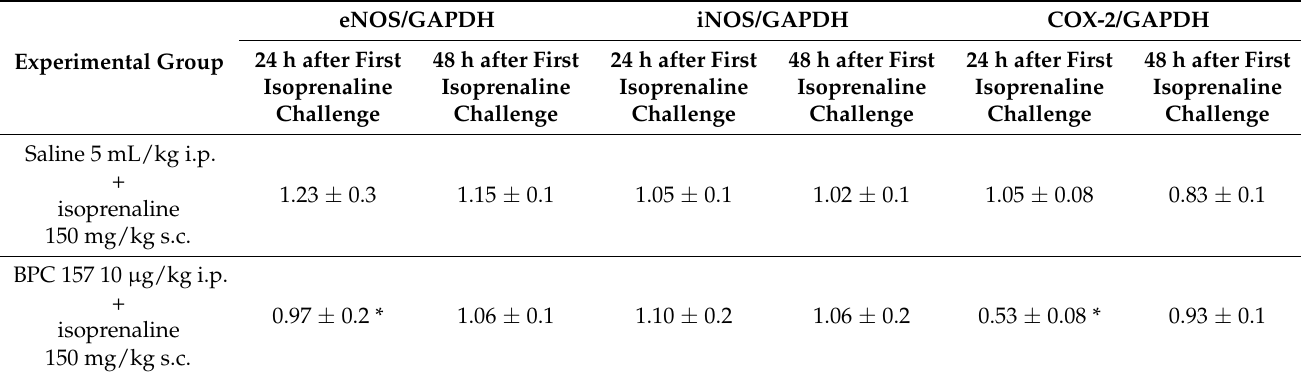
Table 4. eNOS/GAPDH, iNOS/GAPDH, COX-2/GAPDH. Densitometric analysis of RT-PCR prod- ucts showing the effect of BPC 157 on eNOS and COX-2 mRNA levels in heart septum tissue. Results were expressed as the ratio of the optical density of the eNOS PCR and COX-2 products to the density of the corresponding GAPDH PCR products and standardized to 1.0 for controls (relative intensity). Isoprenaline (150 mg/kg s.c., given once (at time 0) or twice, at 0 and 24 h). First challenge for initial infarction induction, assessed at 24 h thereafter; then, at 24 h, the next application (isoprenaline given twice, at 0 and 24 h) for reinfarction induction (assessment at the end of the subsequent 24 h period). Medication (/kg, i.p.) (BPC 157 (10 µ g) or saline (5 mL) (control)) at 30 min before isoprenaline. Means ± S.D. vs. control, * at least p < 0.05, 10 rats per each experimental